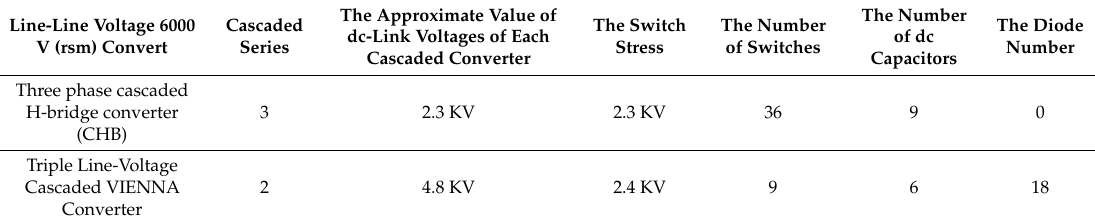
Table 1. The comparison of three-phase CHB and LVC-VC.